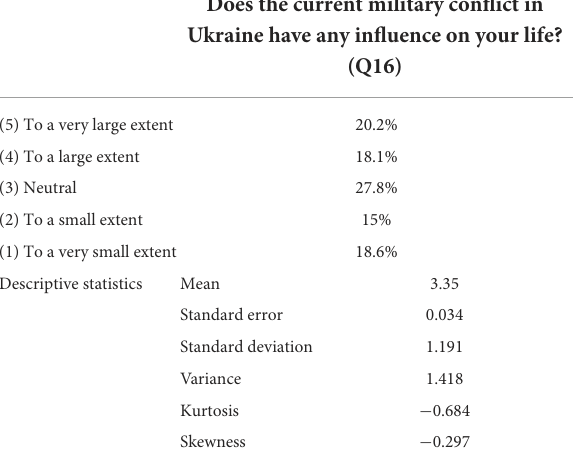
TABLE 8 Participants’ views on the influence of the Ukrainian conflict on their